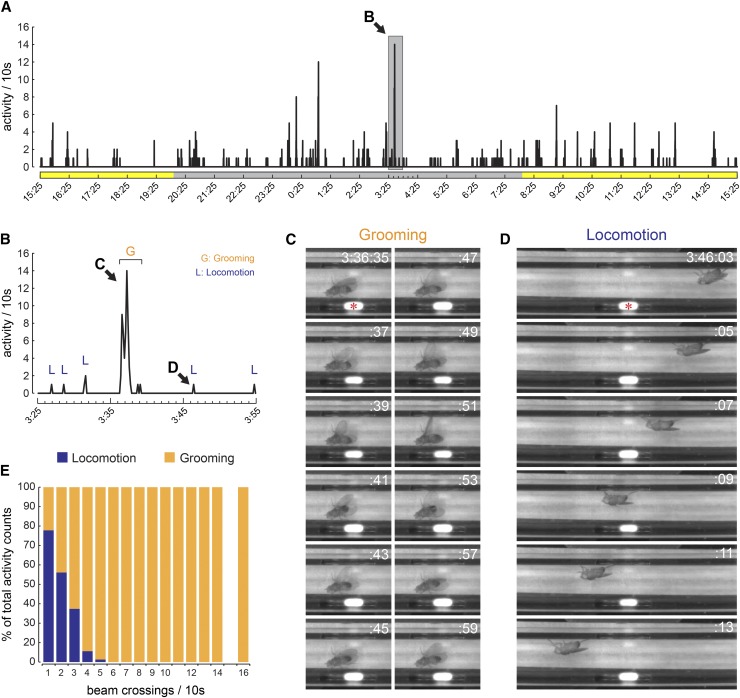
Grooming underlies high-frequency beam crossing events in the infrared activity monitor. (A) Activity of a single nf1P1 fly over 1 d in the activity monitor, in units of beam counts per 10 s bin. The time region expanded in (B) is highlighted with a gray box. (B) Expanded time scale of the 30 min segment highlighted in (A), spanning three 10 min videos. The peaks highlighting grooming and locomotion in (C) and (D) are indicated with arrows. (C) Video stills of a fly grooming next to the infrared beam. The beam breaks were recorded as a large series of activity peaks by the monitor trace in (A) and (B). The IR beam is marked with an asterisk in the first frame. (D) Video stills of a fly walking past the beam. The beam break was recorded as a single peak in the activity trace, marked in (B). The IR beam is marked with an asterisk in the first frame. (E) Proportion of locomotion and grooming events graphed against beam crossing frequency.